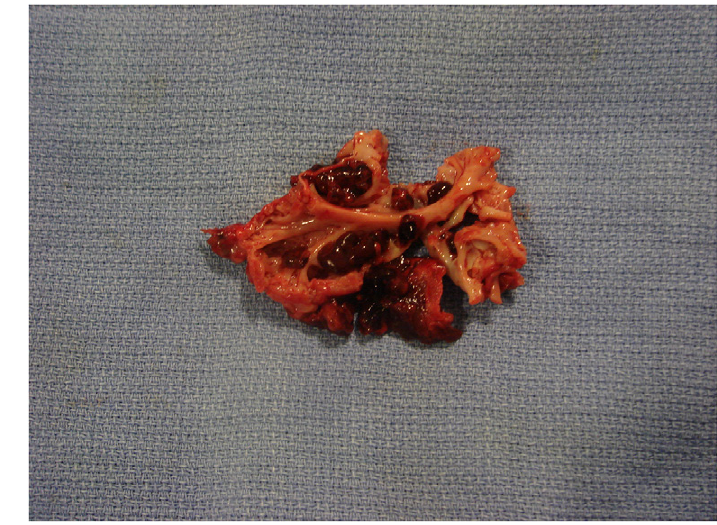
Figure 6. Excised right atrial appendage of a patient with right EMF, aneurysmal right atrium and thrombi attached to its wall. With left EMF, the mitral annulus and inflow part of the left ventricle are exposed through atriotomy. This allows the assessment of distribution and extent of valve lesions in most patients but ventriculotomy may be required for complete evaluation of apical lesions [88]. Surgery consists of conservative endocardectomy and mitral valve repair or